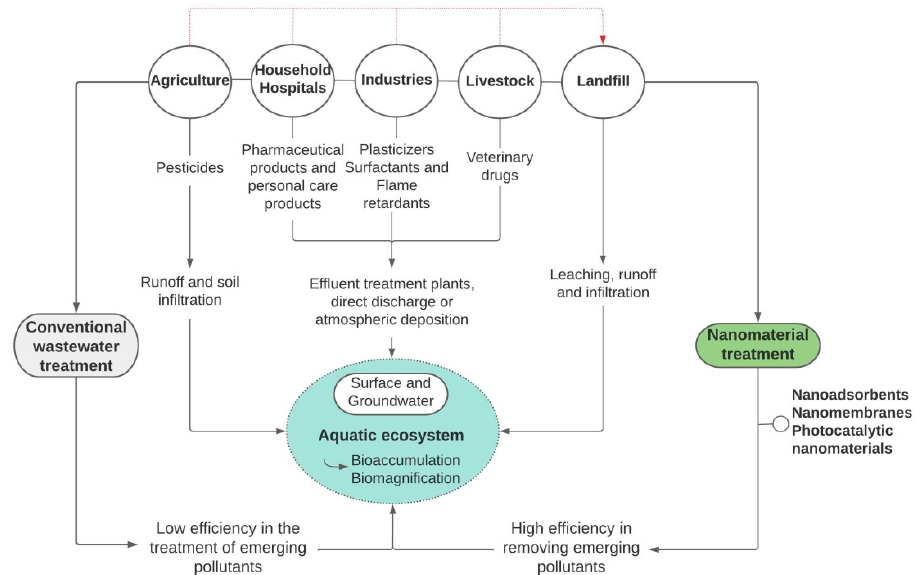
Figure 1. Possible sources of emerging contaminants in aquatic resources.